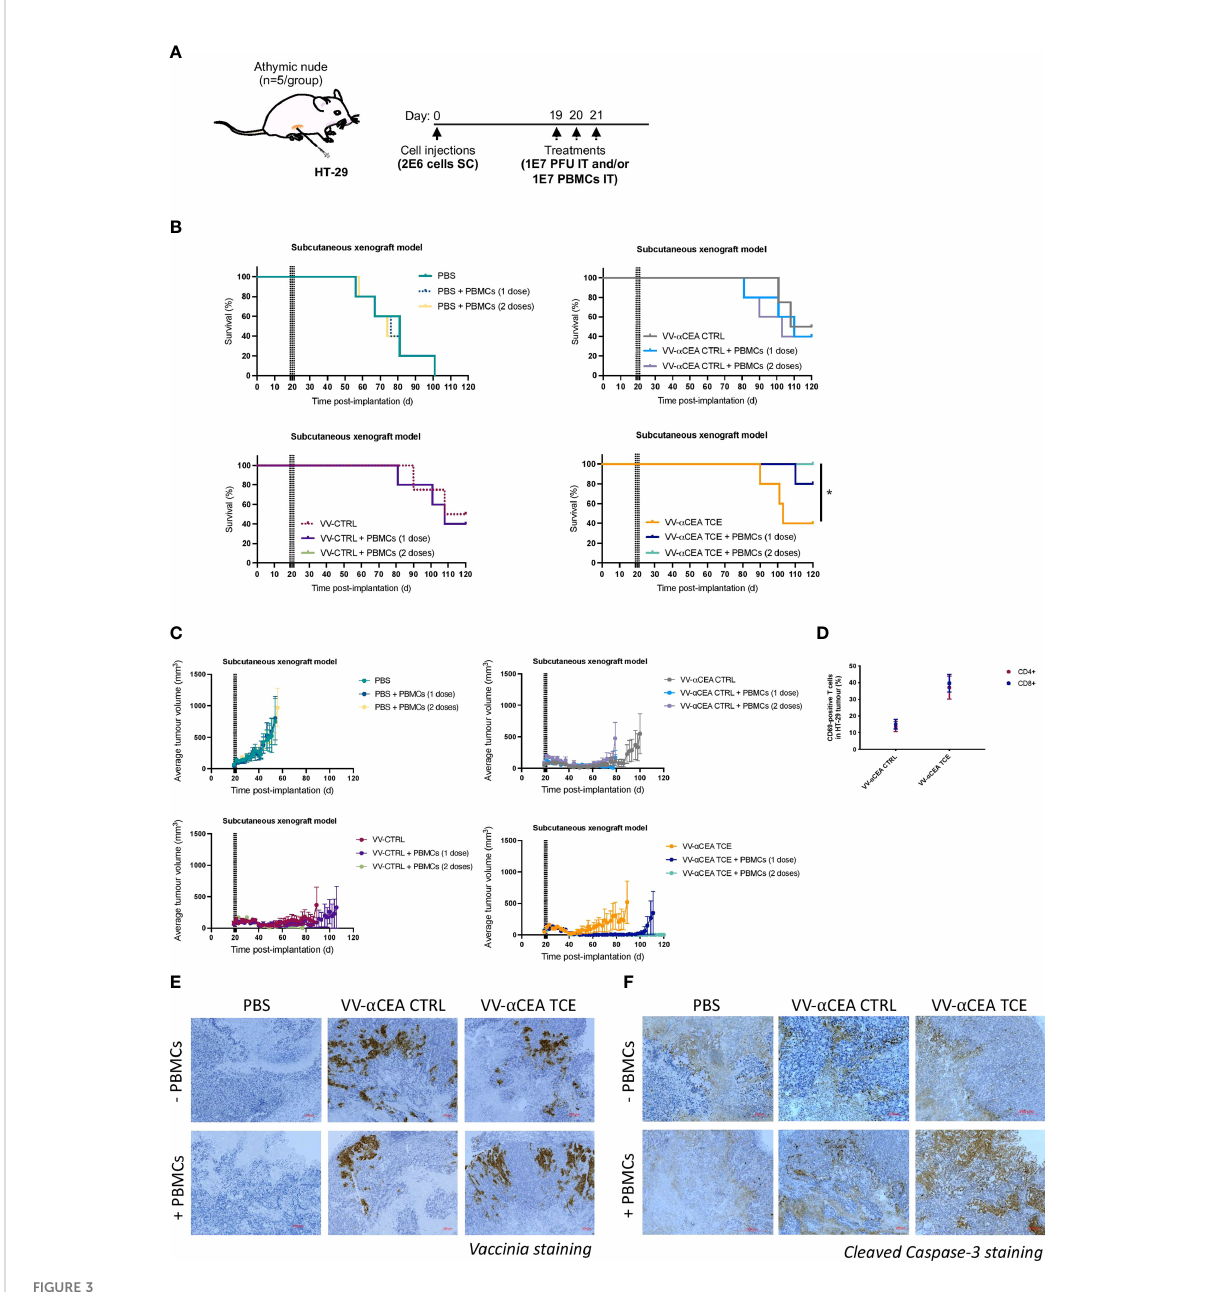
FIGURE 3 Antitumour ef fi cacy of VV encoding TCE in a human xenograft model. (A) Athymic nude mice bearing subcutaneous HT-29 tumours were injected intratumourally with 3 doses of viruses at 1E7 pfu on days 19, 20 and 21. Approximately 5 h after virus injections, mice were also co-injected intratumourally with freshly isolated PBMCs at 1E7 per condition, or PBS control, on day 19 only, or co-injected intratumourally with freshly isolated PBMCs at 1E7 per condition, or PBS, on both days 19 and 21. (B) Antitumour ef fi cacies of VV-CTRL, VV- a CEA TCE ( a CEA:hCD3), and VV- a CEA CTRL ( a CEA:mCD3) viruses were evaluated in combination with one or two doses of PBMCs. Treatment with viruses alone showed signi fi cantly prolonged survival (40-50% cures), compared to PBS treatment and regardless of PBMC presence. Highest survival rates were observed in mice treated with VV- a CEA TCE and PBMCs, with 100% survival of mice treated with 3 doses of VV- a CEA TCE and two doses of PBMCs. (C) Mice bearing HT-29 tumours co-injected with VV- a CEA TCE and two doses of PBMCs had the most signi fi cant decrease in average tumour volumes. (D) T cells isolated from HT-29 tumours 24 h after the last dose of injection with VV- a CEA TCE and PBMCs showed an increase in expression of the T cell activation marker CD69, while injection of VV- a CEA CTRL had little effect relative to PBS treatment. (E) Vaccinia virus was detected in HT-29 tumours 24 hpi by immunohistochemistry (IHC) in conditions treated with VV- a CEA TCE ( a CEA:hCD3) or VV- a CEA CTRL ( a CEA:mCD3), but not PBS control. Scale bar = 200 µm. (F) Active caspase-3 was predominantly detected in HT-29 tumours 24 hpi by IHC in conditions co-treated with VV- a CEA TCE ( a CEA:hCD3) and PBMCs, compared to other virus and no PMBC conditions. Scale bar = 200